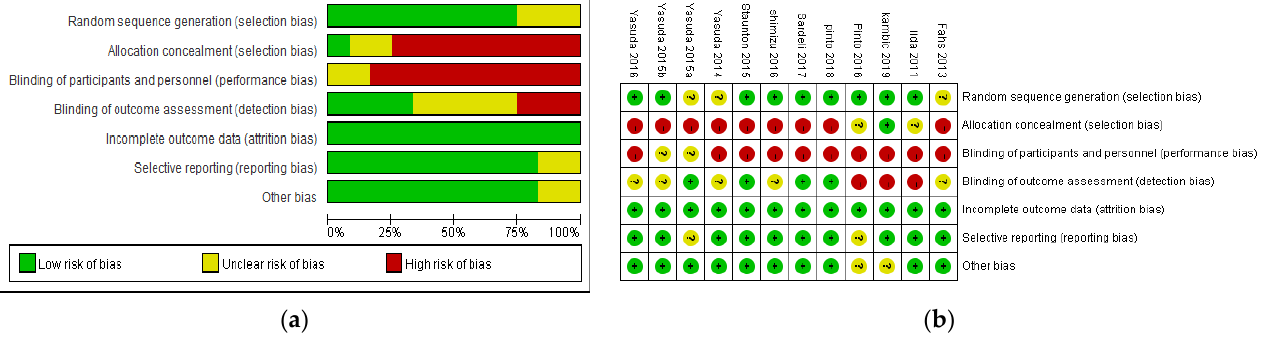
Figure 2. ( a ) Risk of bias graph; ( b ) Risk of bias summary.